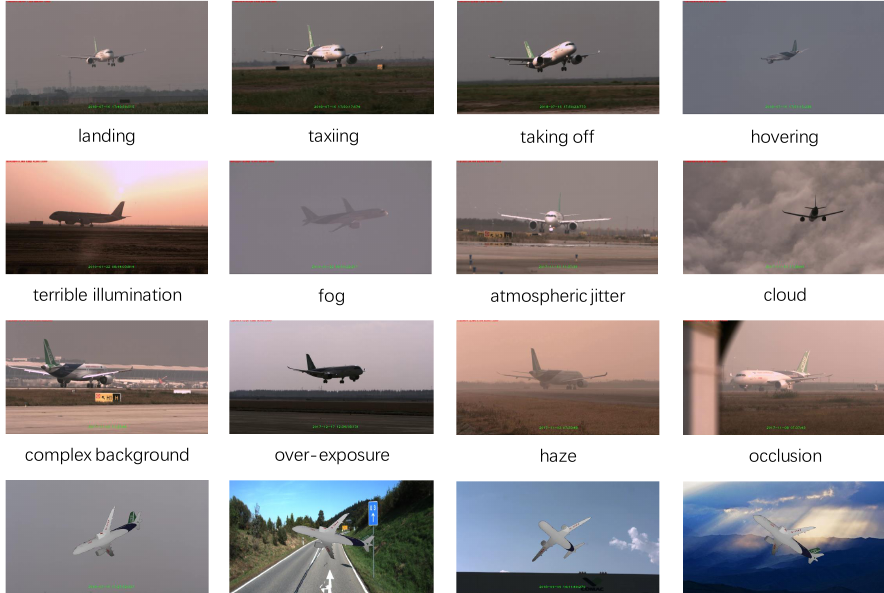
Figure 11. Examples of images in the APE dataset. The first three rows are real images which are under different pose and weather scenes. The fourth row is rendered images which are under different pose and